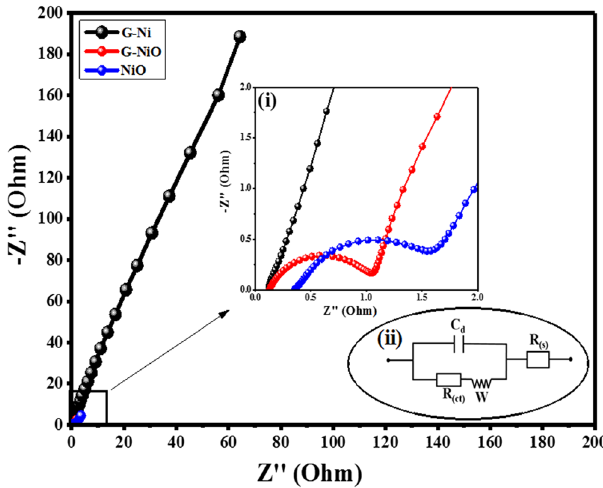
Figure 5. Nyquist plots of G-Ni, NiO, and G-NiO electrode; inset (i) shows the expanded EIS spectra revealing the corresponding charge-transfer resistances and inset (ii) the equivalent represents the circuit diagram for the